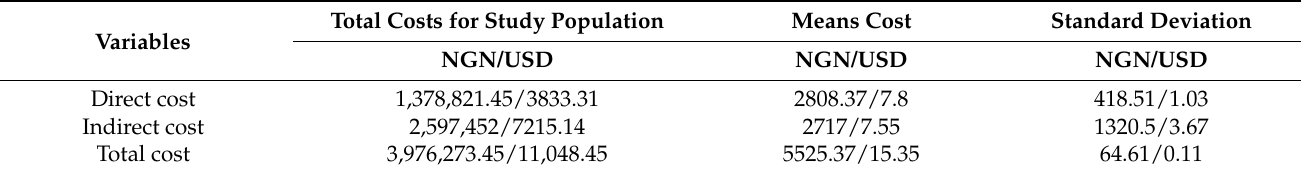
Table 6. Economic burden per case of uncomplicated malaria per patient and study population in Plateau state (in Naira) (NGN) (Nigeria currency/USD) ( N = 956).